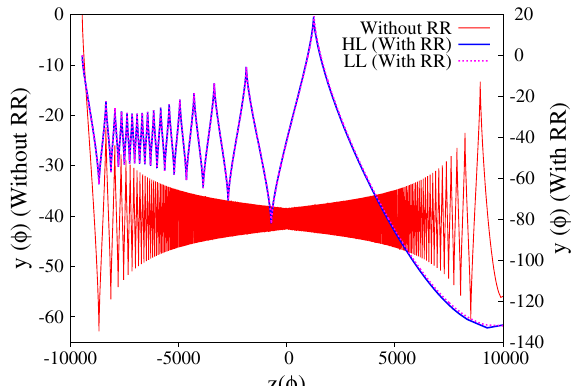
Figure 8. Represent the trajectory of the particle in the absence/presence of radiation reaction effects. The chosen initial conditions and the laser parameters are same as in Fig. 7. The red curve represent the motion of the particle in the absence of radiation reaction (values correspond to y-axis on the left). The blue and magenta curve respectively represent the trajectory of the particle in the presence of radiation reaction effects (values correspond to y-axis on the right)as obtained by solving the Hartemann-Luhmann and the Landau-Lifshitz equation of motion. Note that the apparent discrepancy in the initial conditions seen in the above figure for without and with radiation reaction is due to the use of different axes i.e. left y-axis is for without radiation reaction and right y-axis is for with radiation reaction